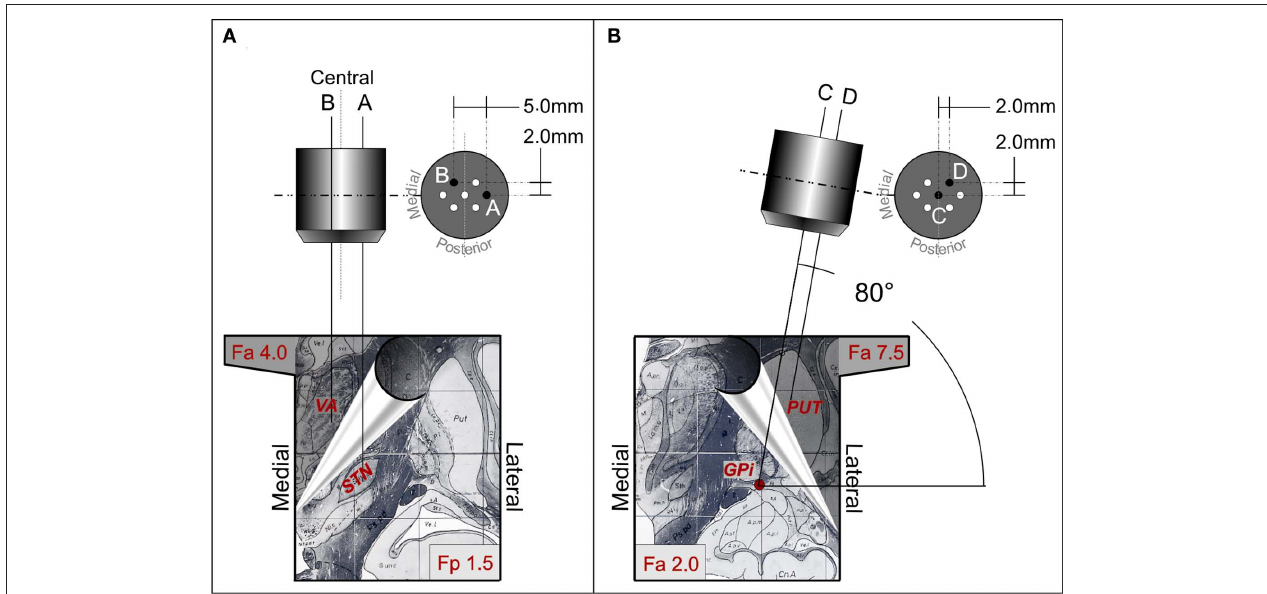
trajectory was 1.5 mm more medial than the central one and 2 mm more anterior. The probe membrane (4 mm length) was positioned between 11.0 and 7.0 mm above the target ( + 7 to + 3 mm above the inter-commissural plane), along the trajectory of electrode B. Given the angle in the sagittal planes (70 ° –75 ° ), the trajectory had a laterality of 7.0 mm and, at the level of + 7 to + 3 mm above the inter-commissural plane, its antero-posterior position was between + 6.0 and + 4.0 mm with respect to the midpoint of the inter-commissural line, corresponding to the center of VA. After electrophysiological identification of the targets, the recording electrode in the GPi was replaced by a microdialysis probe [trajectory C in (B) ]. A second probe was positioned in trajectory D, at the level of PUT [D in (B) ], utilizing the antero-lateral hole of the multi-electrode holder according to the coronal angle used. Probe membrane was positioned at a laterality between 22.5 and 25.0 mm, a depth of + 9.0 with respect to the inter-commissural plane, and between + 4.8 and + 7.5 mm anterior to the midpoint of the inter-commissural line. Probes and stimulating electrode real positions were verified during surgery by X-ray in antero-posterior and